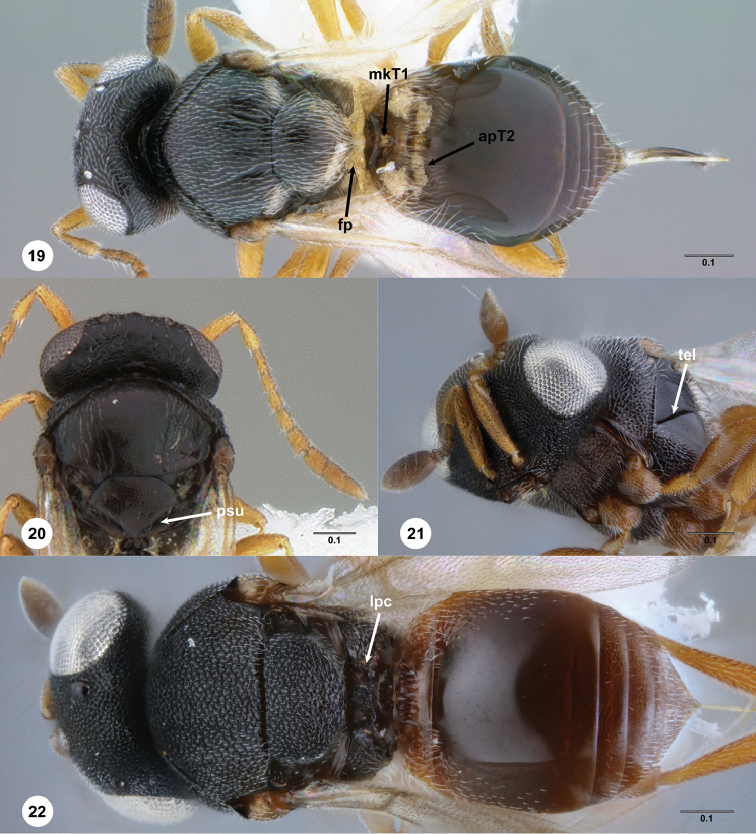
19Helavaaureipes Masner & Talamas female holotype (USNMENT00989205), head, mesosoma, metasoma, dorsal view 20Alfredella sp. female (USNMENT00916677), head, mesosoma, dorsal view 21Aphanomerus sp. female (USNMENT01109890), head, mesosoma, ventrolateral view 22Aphanomerus sp. female (USNMENT01109890), head, mesosoma, metasoma, dorsal view. Scale bar: in millimeters.